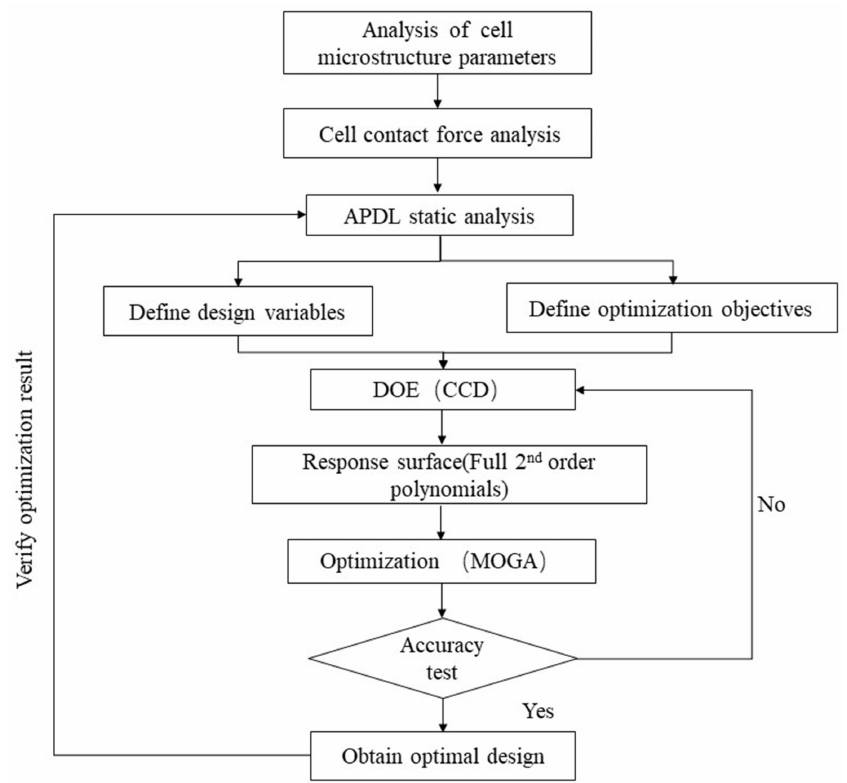
Figure 1. Flow chart of cell microstructure